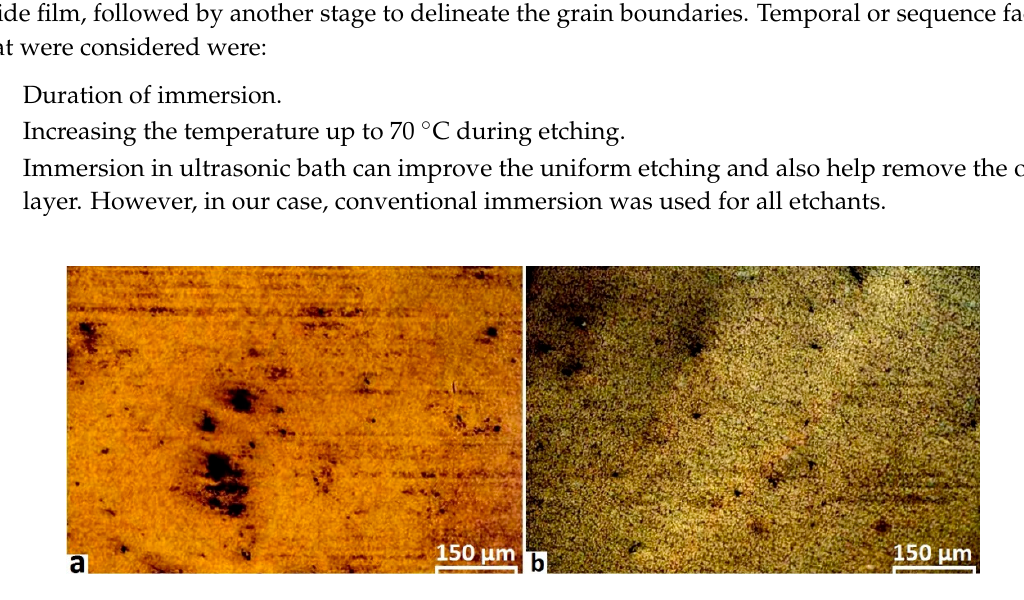
Figure 2. Etched surface of the A6082-T6 weldments, ( a ) the Keller’s reagent and ( b ) Kroll’s reagent. These reagents are unsuccessful at elucidating the microstructure for this material.